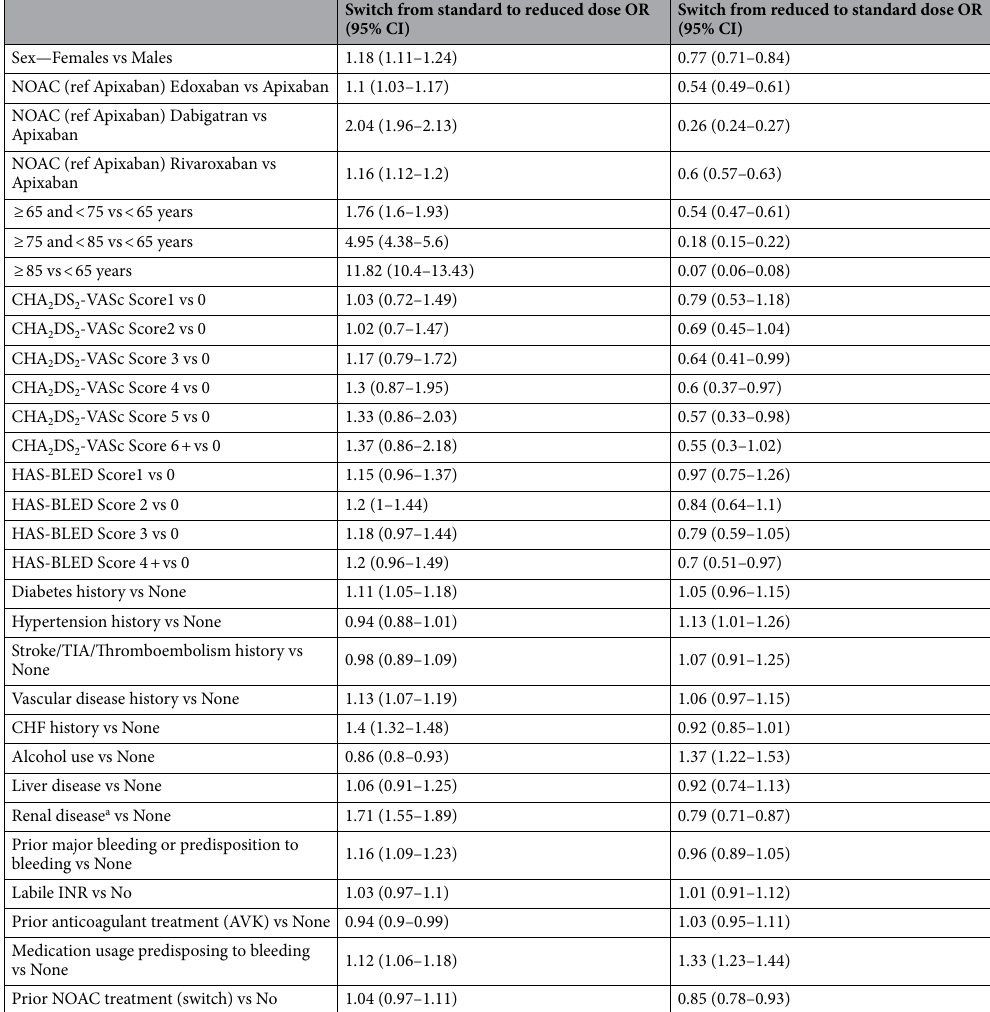
Table 3. Factors associated to the switch from standard to reduced dose and from reduced to standard dose in 31,171 s prescriptions. Data are expressed as odds ratio and confidence intervals for the baseline characteristics and previous NOAC treatment. a Renal disease = renal transplantation or dialysis or plasma creatinin > 200 µmol/L.